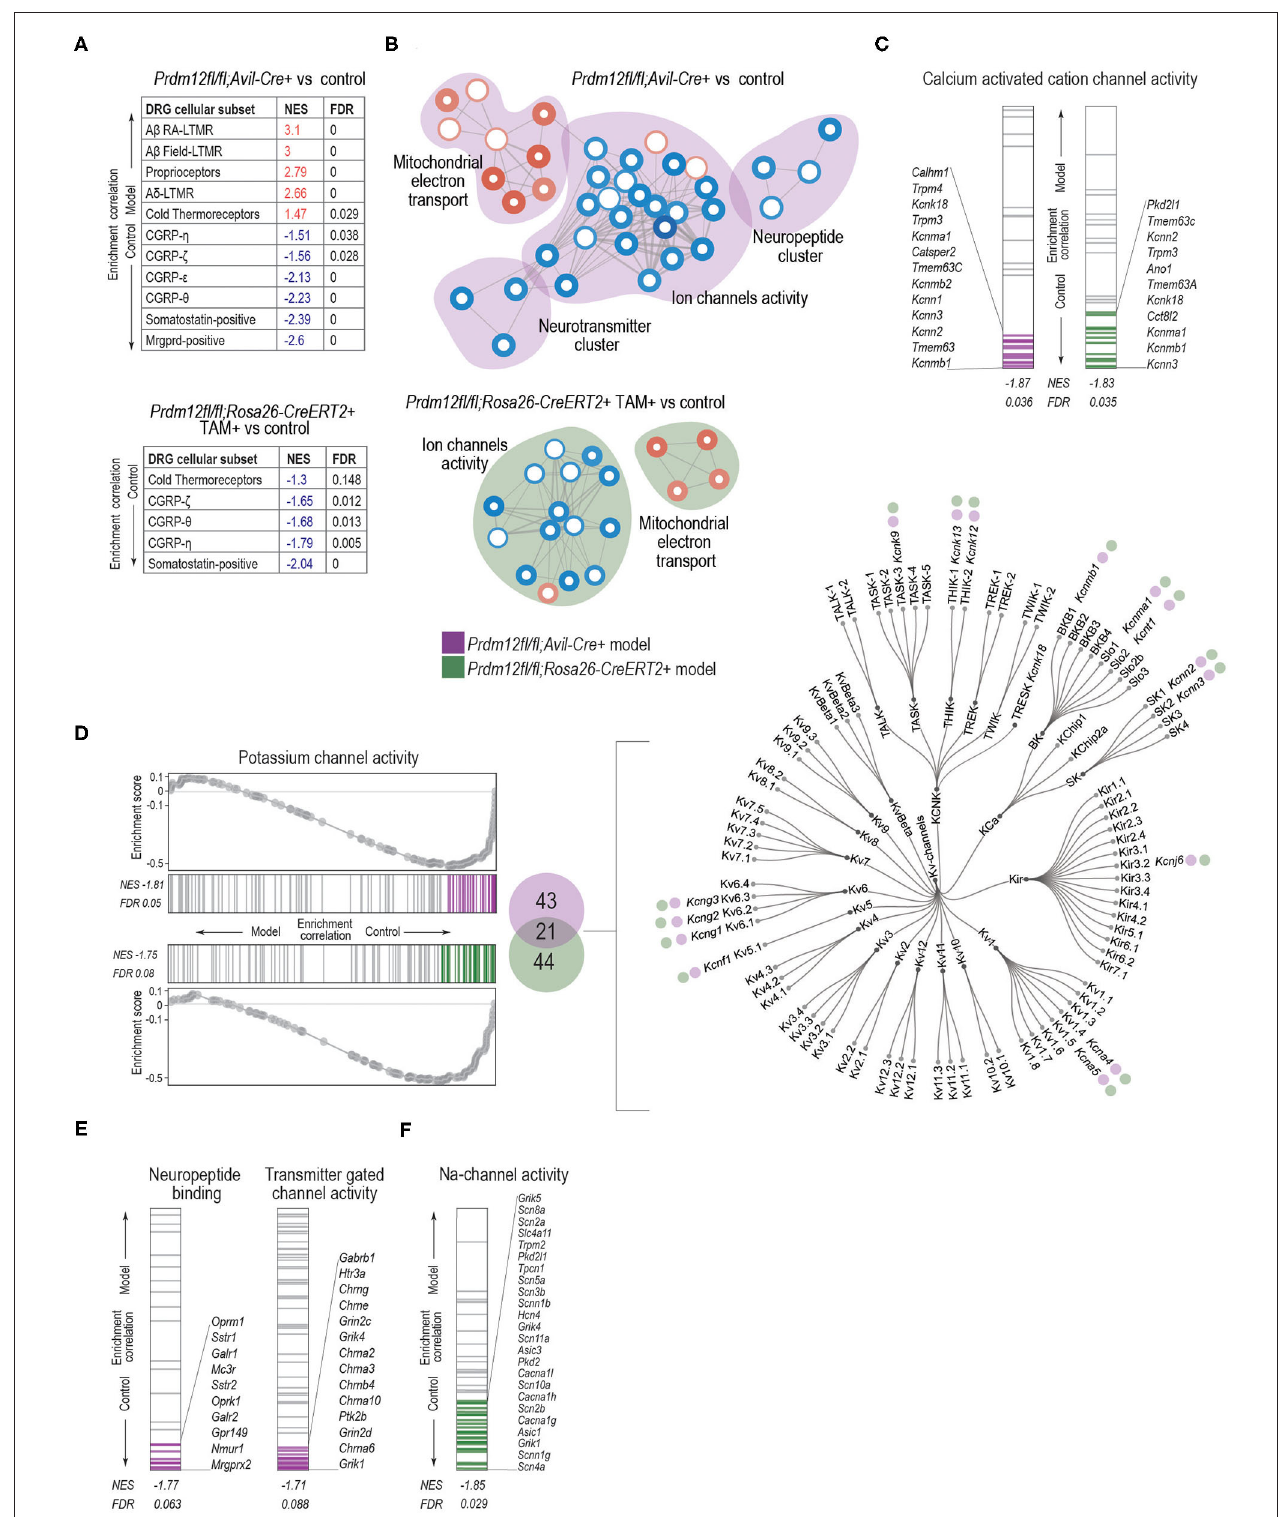
FIGURE 6 | GSEA analysis with enrichment mapping shows distinct clusters of dysregulated MF:GO terms. (A) Dysregulation of bulk RNA DRG transcriptomes as demarked by gene sets most significant by sensory neuron subtypes detected in the DRG, for both Prdm12 fl / fl ; Avil-Cre + (top table) or TAM-injected Prdm12 fl / fl ; Rosa26-ER T 2 + (bottom table) as detected by GSEA with the cutoff value of p of 0.05 and FDR cutoff of 0.25. (B) Clusters of GSEA enriched-term nodes in the GO:MF terms. Nodes in red either in Prdm12 fl / fl ; Avil-Cre + (pink cloud, left) or in Prdm12 fl / fl ; Rosa26-ER T 2 + (blue cloud, right) are enriched in DRG, while nodes